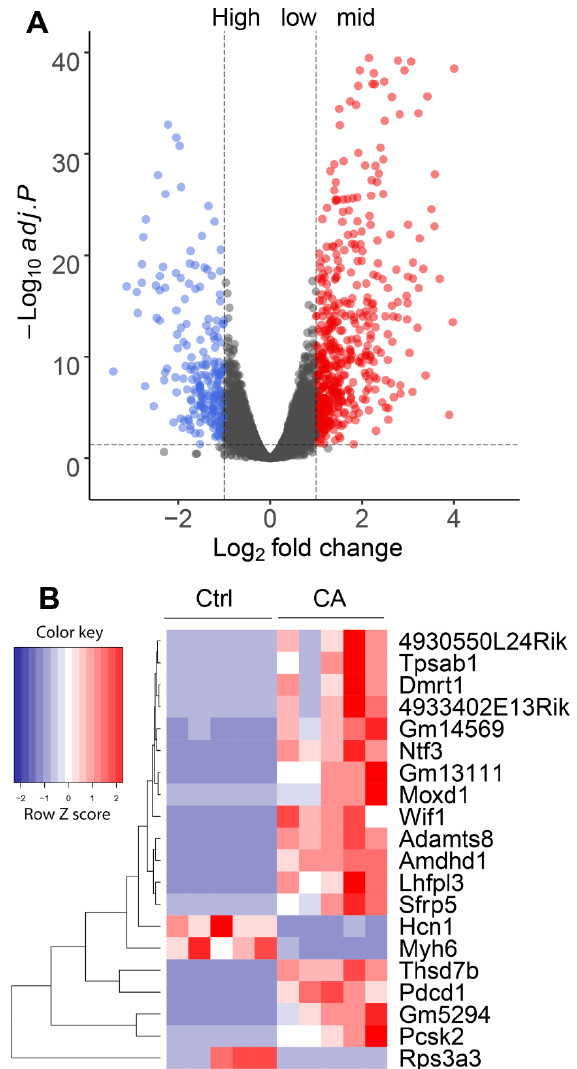
Figure 1. RNA-seq analysis of ovaries from TGFBR1-CA and control mice at the age of 1 month. ( A ) Volcano plot depicting genes identified by RNA-seq. Genes with Log 2 fold change greater than 1 (red) or less than −1 (blue) and adjusted p -values less than 0.05 were defined as DE genes. A total of 715 DE genes were identified, with 499 upregulated genes and 216 downregulated genes in the ova- ries of TGFBR1-CA mice compared with age-matched controls. n = 5 per group. ( B ) Heatmap of the top 20 DE genes. Heatmap was generated using row Z scores. A full list of DE genes is shown in Supplementary Table S1.